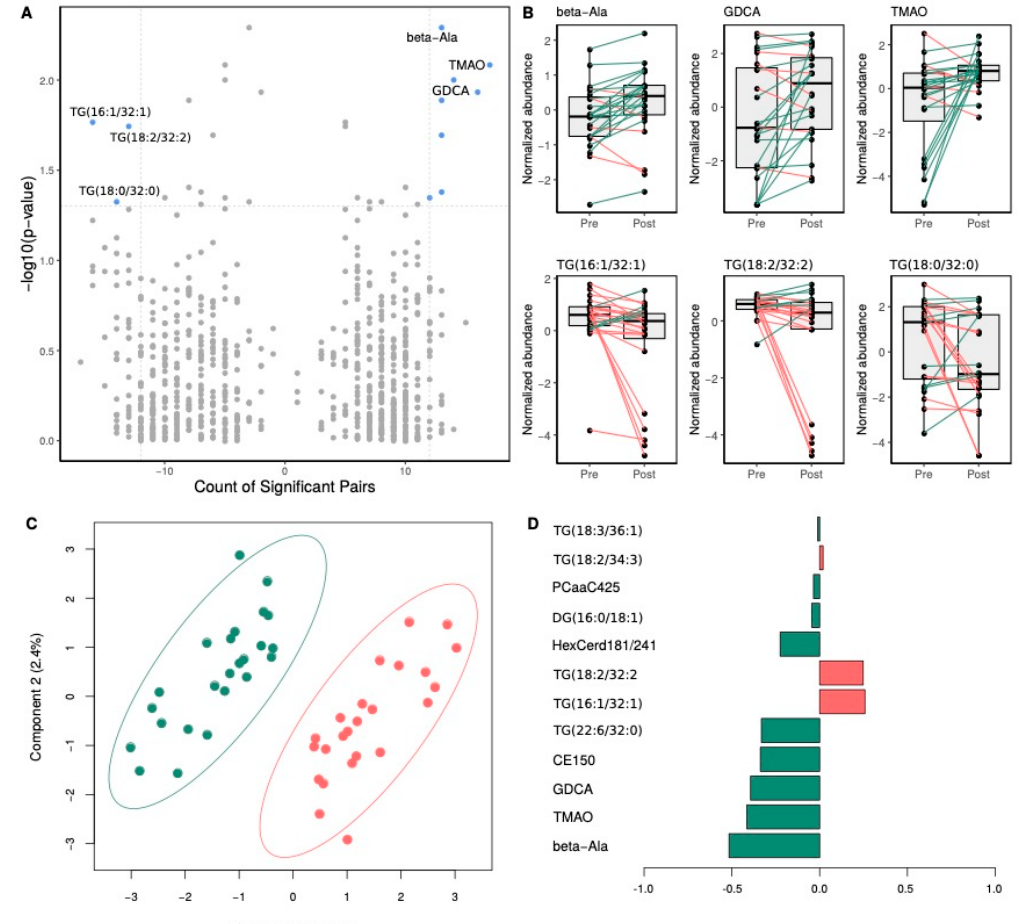
Figure 4. Impact of Rb supplementation on plasma metabolite levels. Panel ( A ) shows a volcano plot of paired comparisons between metabolite plasma levels in pre- and post-supplementation groups. On the x-axis, a count of significant sample pairs is shown. On the y-axis, the minus logarithm of paired t-test p -values is shown. Metabolites showing statistically significant changes following the Rb supplementation ( p -value < 0.05 and fold change > 1.25) are depicted as blue dots on the right (increase) and left (decrease) top corners. Top-three significantly different metabolites of both increasing and decreasing values are labeled. Panel ( B ) shows top metabolites showing significant changes following Rb supplementation. Box and whisker plots show median, first, and third quartiles, and maximum and minimum values for the 24 sample pairs before (Pre) and after (Post) the Rb supplementation. The three metabolites, which exhibited the most significant decrease and increase following the supplementation, are shown on the top and bottom rows, respectively. Green and red lines stand for increasing or decreasing plasma metabolite levels between pre- and post-supplementation states within individual paired samples. Panel ( C ) shows a bi-dimensional score plot depicting the distinct plasma metabolomic profile between pre- (red dots) and post-supplementation (green dots) paired participants. The two principal components of the smPLS-DA model along with their corresponding variance in group discrimination are shown on y- and x-axis, respectively. Panel ( D ) shows a loading plot representing the top 10 metabolites selected on the first component of the smPLS-DA model. Most important metabolites in group discrimination are ordered according to their loading weights (horizontal bars), from bottom to top. Bar color indicates the group for which the mean value is the highest for each feature (orange and green stand for pre- and post-supplementation groups,